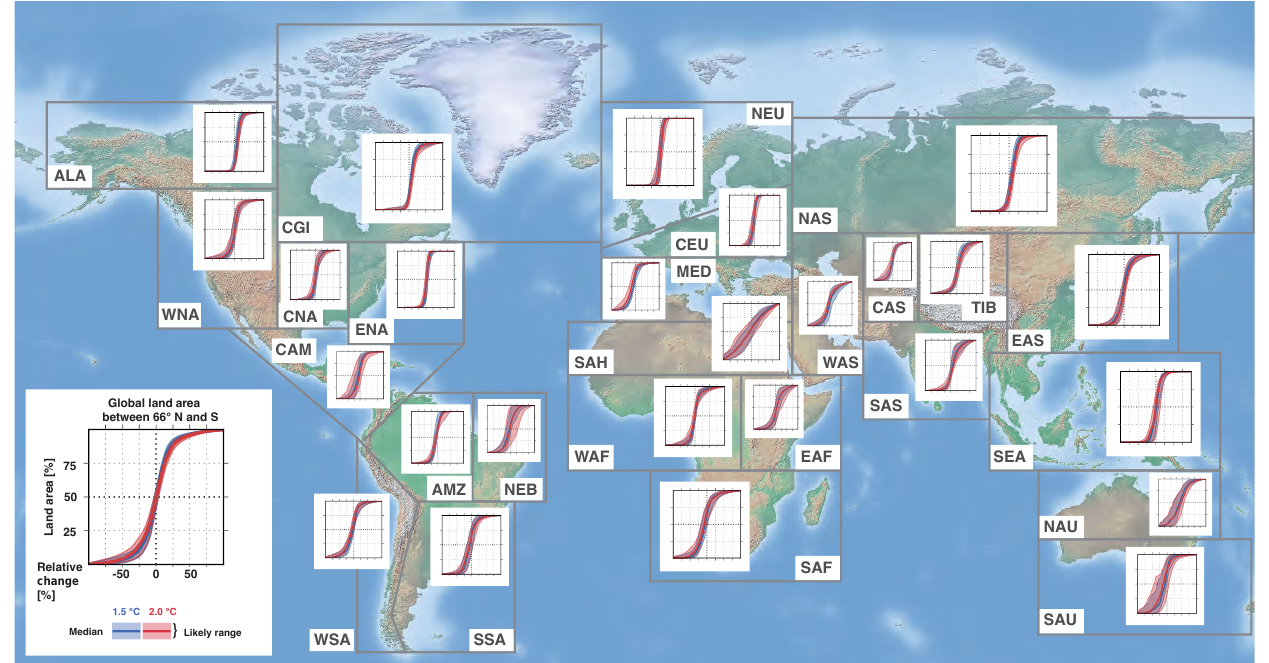
Figure 8. Same as Fig. 2 but for total annual runoff. Changes are given relative to the 1986–2005 reference